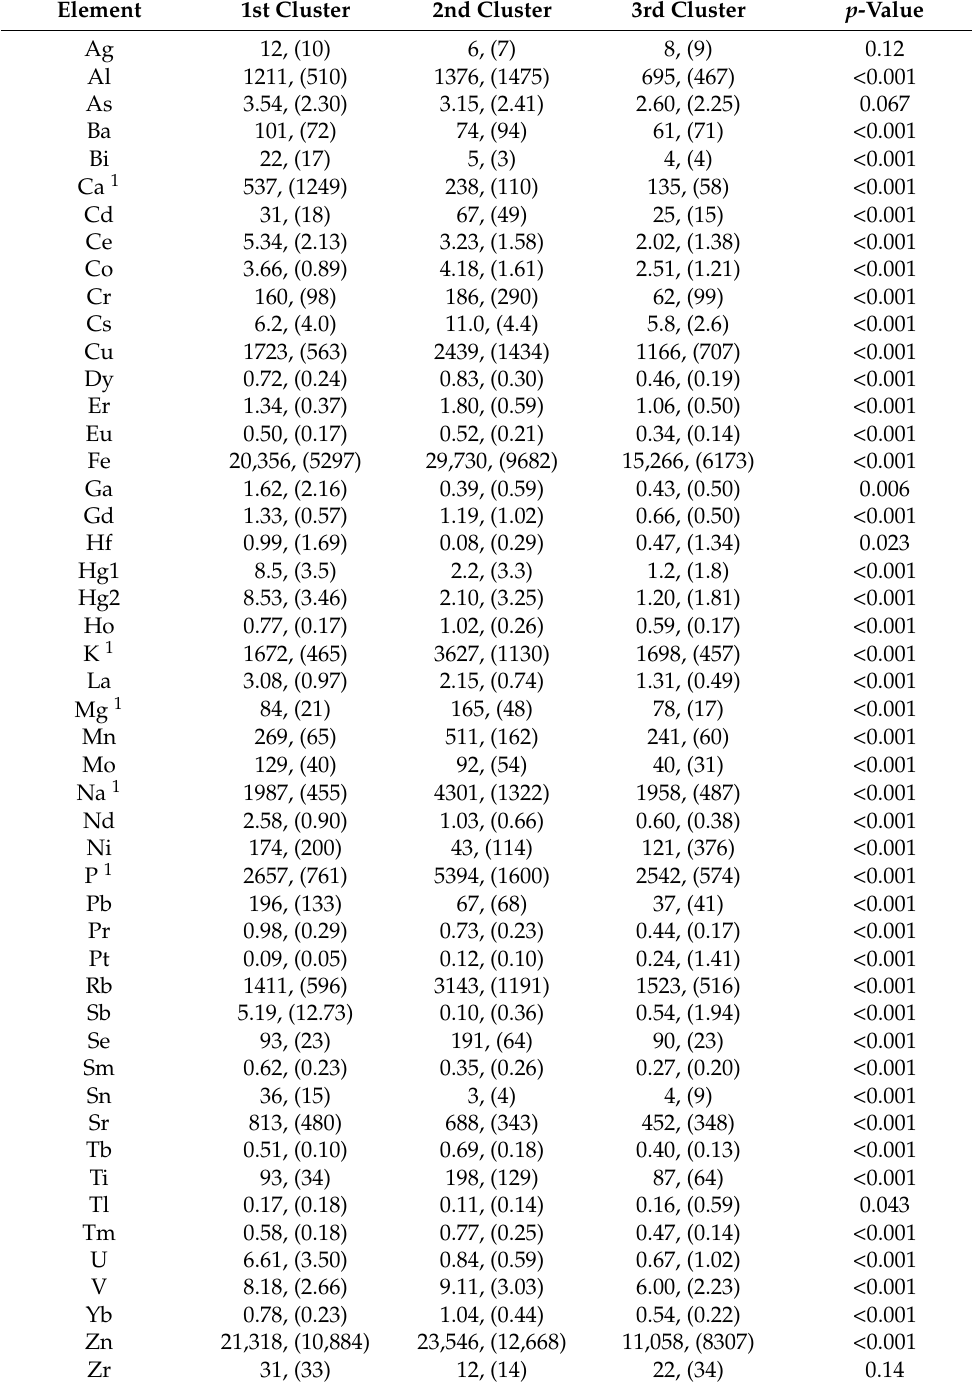
Table 3. The elements’ mean, (SD) values in ppb with a significance of division into clusters ( p -value) calculated using the Kruskal–Wallis rank-sum